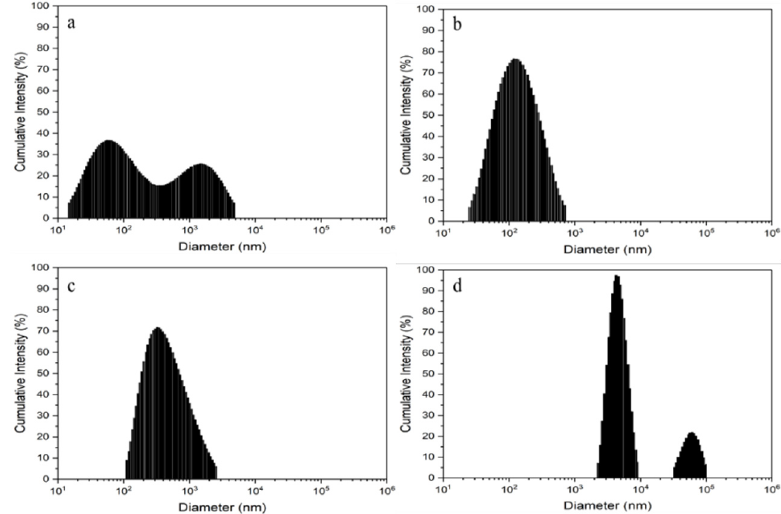
Figure 4. Intensity distribution of particles in the colloidal samples: ( a ) Baked 1, ( b ) Baked 10, ( c ) Baked 100 and ( d ) Unbaked 10.